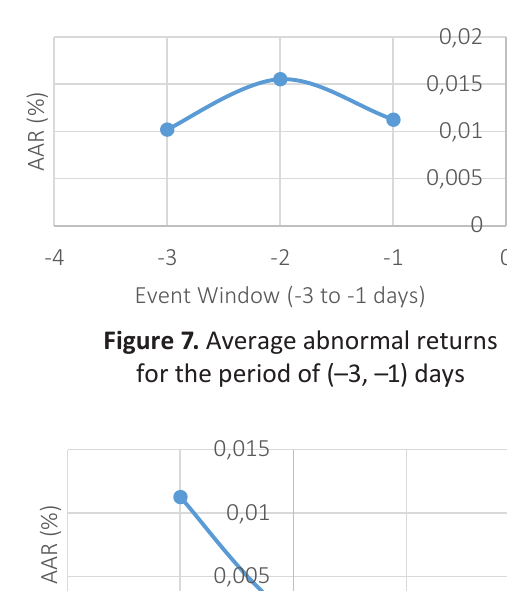
Figure 5. Average abnormal returns for the period of (–15, –1) days